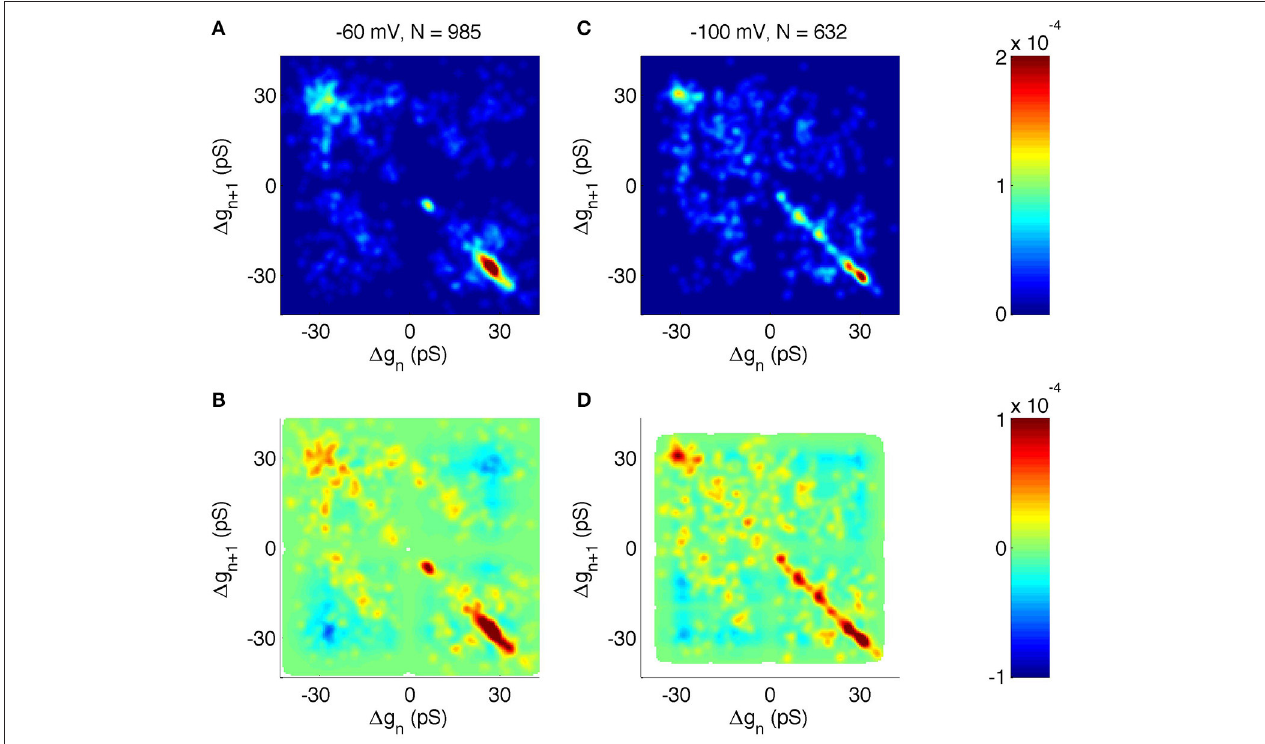
FIGURE 7 | Correlation analysis of neighboring events in PIEZO1 channels recorded at − 60 and − 100 mV holding potentials. As in other figures, x and y scales are arranged so that open events followed by closed events populate the lower right quadrant. (A) Distribution of neighboring events at − 60 mV. The x -axis shows 1 g of event n and the y -axis shows 1 g of the following event, n + 1 . (B) Correlation of neighboring events at − 60 mV. Red indicates neighboring events occurring more frequently than random. Blue indicates neighboring events occurring less frequently than random. White areas indicate undefined correlations. (C, D) same as (A,B) but for − 100 mV holding